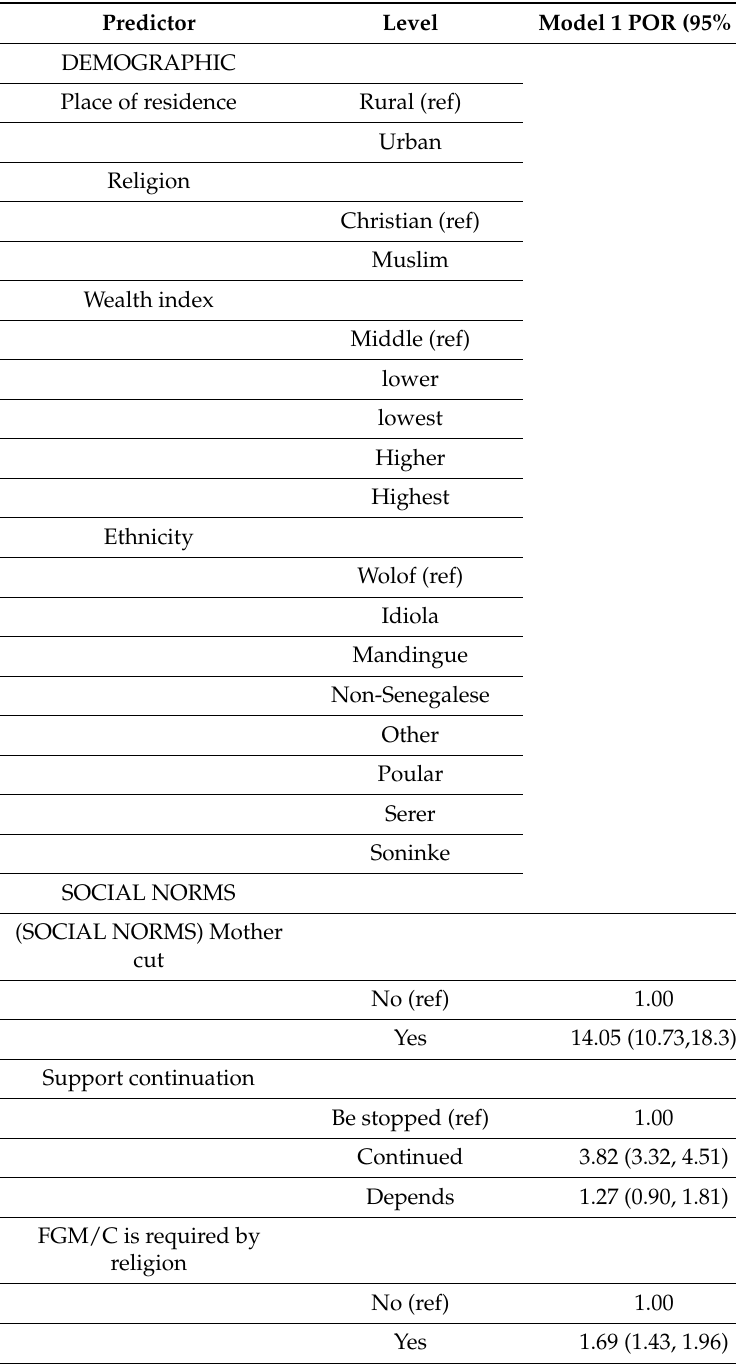
Table 3. Unadjusted and adjusted posterior odds ratios (POR) and associated 95% credible regions of circumcision of girls, ages 0–14, across selected covariates (Senegal, DHS 2017) from Bayesian geo-additive